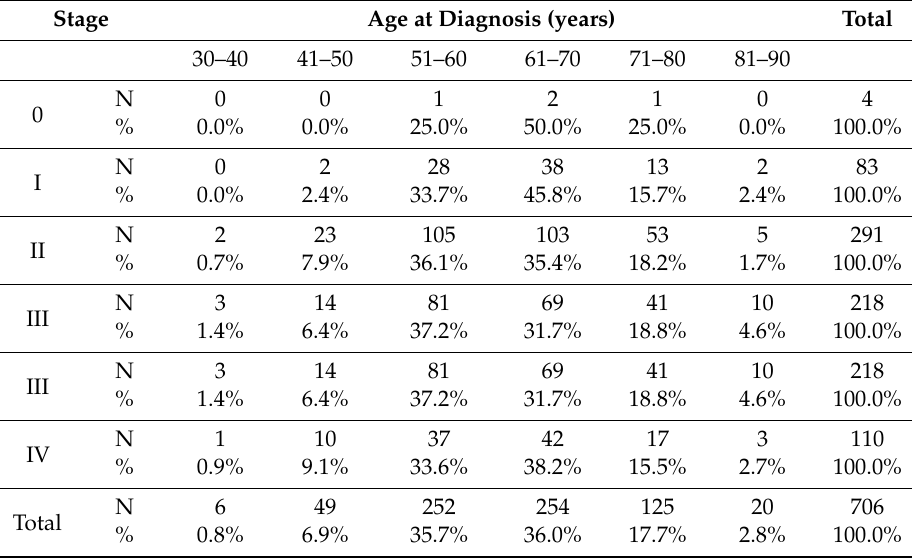
Table 4. Stage related to age.